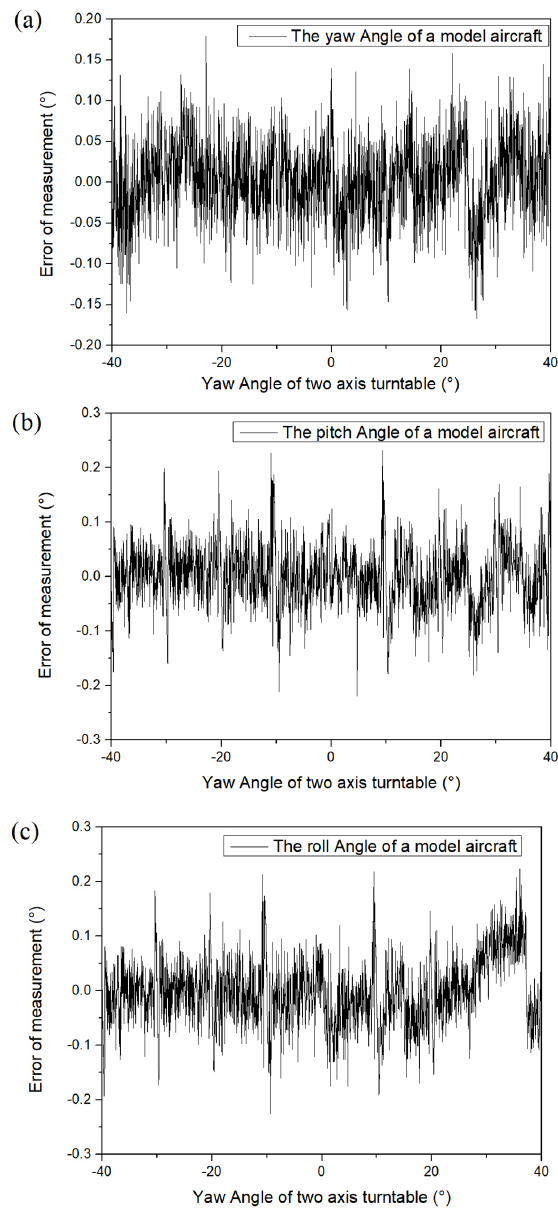
Figure 12. ( a ) Yaw angle measurement error; ( b ) pitch angle measurement error; ( c ) roll angle meas ‐ urement error. measurement error. Table 5. Comparison of registration methods (average point cloud size: